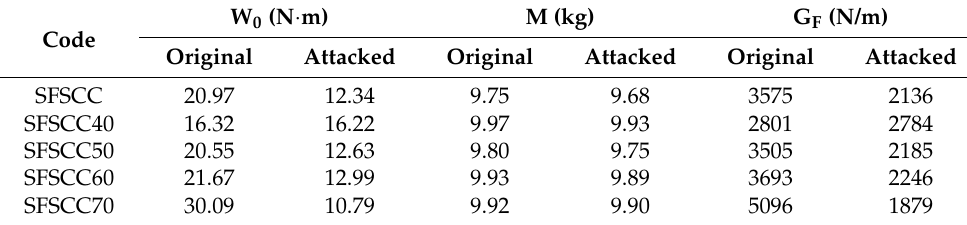
Table 5. The fracture energy of SFSCC before and after sulfate attack.